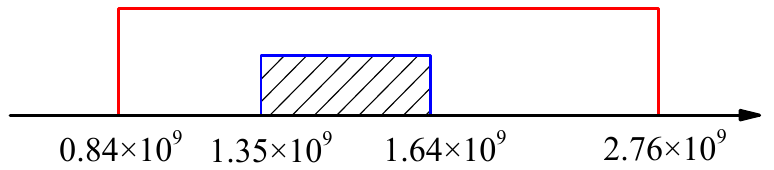
Figure 11. Comparison of torsional sti ff ness and ultimate torsional sti ff ness at interval (unit: N · m 2 / Figure 11. Comparison of torsional stiffness and ultimate torsional stiffness at interval (unit: N·m 2 /rad). Figure 11. Comparison of torsional stiffness and ultimate torsional stiffness at interval (unit: Figure 11. Comparison of torsional stiffness and ultimate torsional stiffness at interval (unit: N·m 2 /rad). N·m 2 /rad).